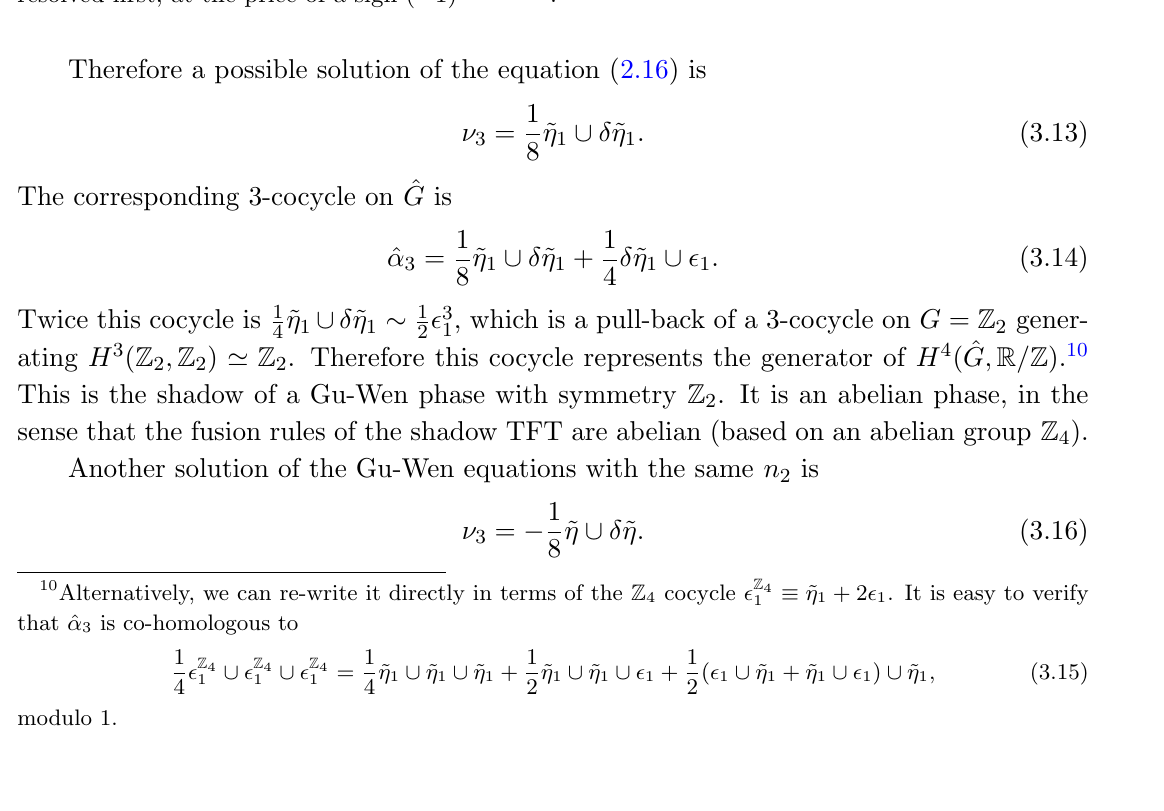
Figure 20 . Intermediate computational steps relating ^ (cid:11) 3 and (cid:23) 3 . The planar intersections (white circles) of center lines can be collapsed together safely, but the non-planar intersection has to be resolved (cid:12)rst, at the price of a sign ( (cid:0) 1) n 2 ( g;g 0 ) (cid:15) 00